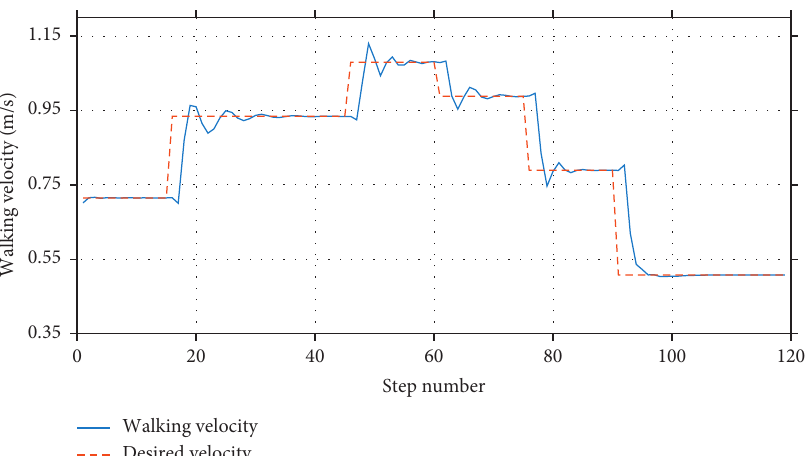
Figure 8: Following a predefined speed profile. The overshoot is less than 5% in all the transitions, and it takes three to four steps before the robot settles to its new speed.